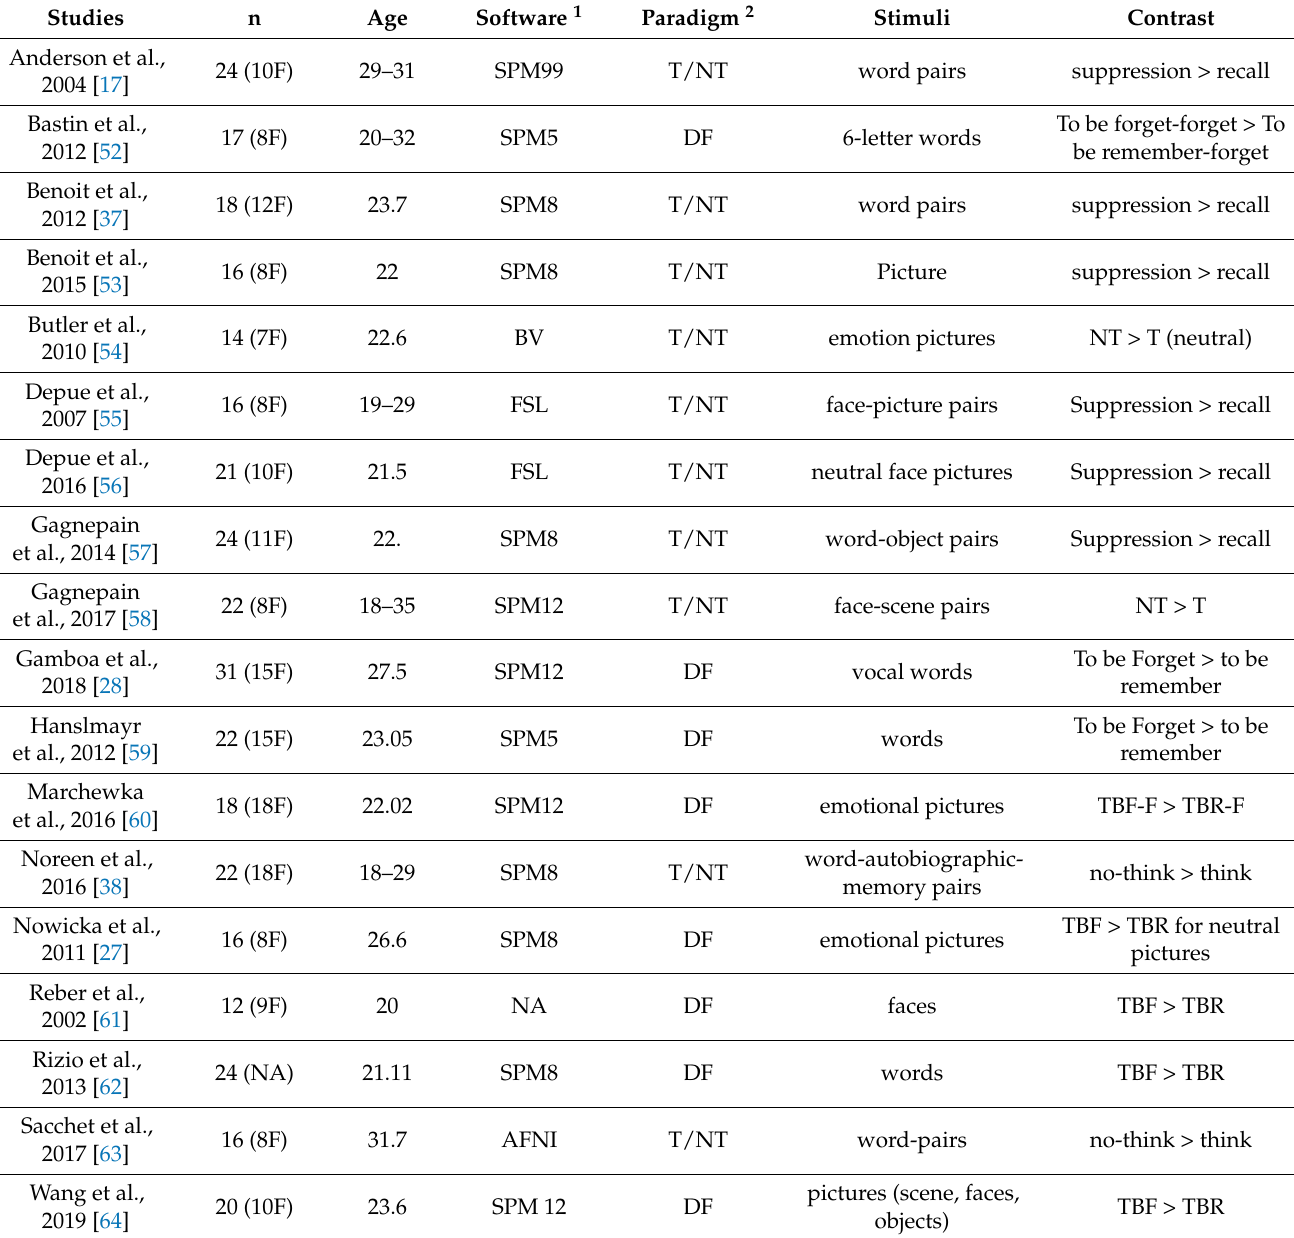
revealed a one-factor solution as the most optimal model (Figure 1D). The latent cognitive component revealed by this solution is highly similar to the ALE analysis, showing the involvement of bilateral middle frontal gyri, bilateral IPL, plus additional brain networks not revealed by ALE, involving bilateral hippocampal complex, precuneus, bilateral middle cingulum, primary visual cortex and cerebellum (Table 2, Figure 1E). Table 1. List of fMRI studies included in the current